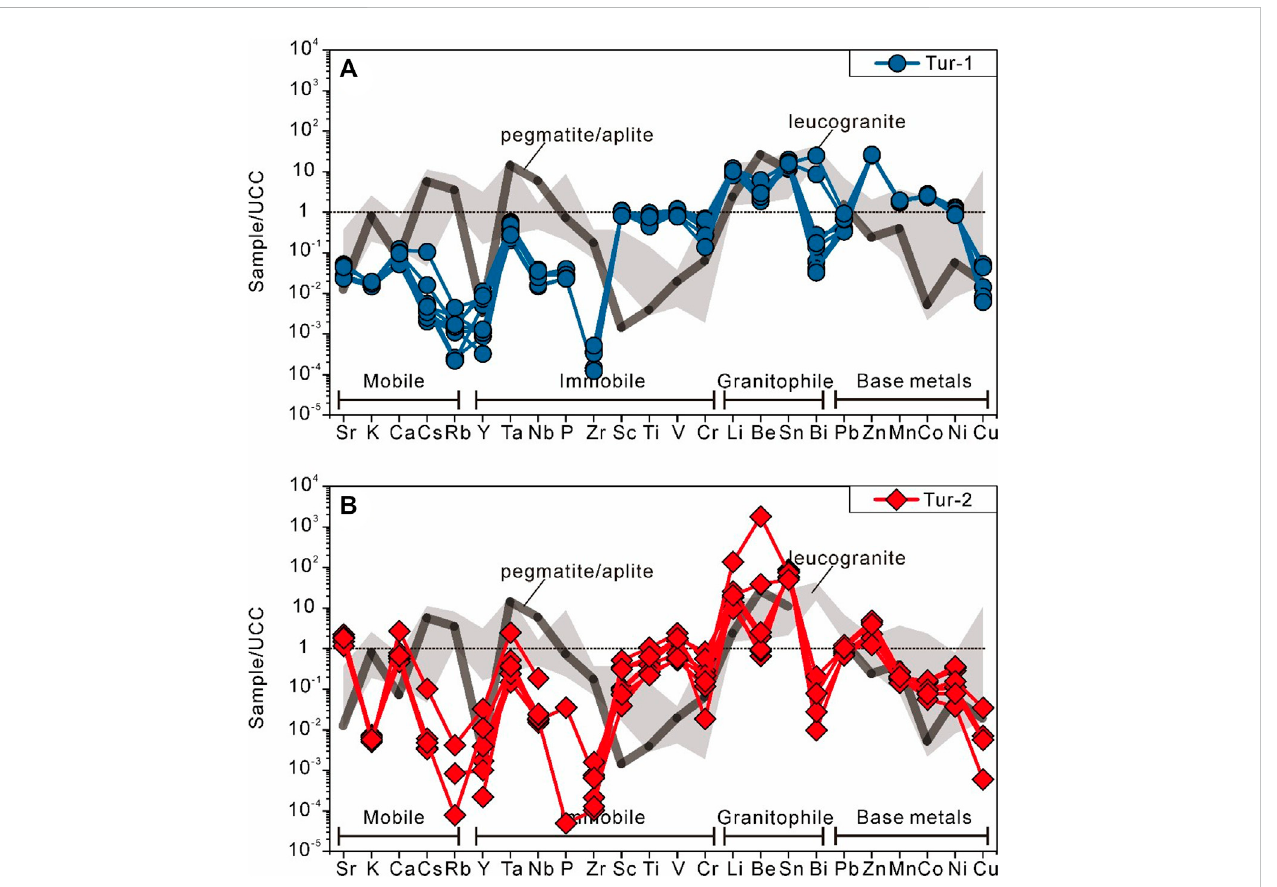
FIGURE 5 Upper continental crust-normalized spider diagram of Tur-1 and Tur-2 from the Cuonadong polymetallic deposit. The upper continental crust data and the classi fi cation of trace elements are from Rudnick and Gao (2003) and Decrée et al. (2013). The whole-rock major and trace element data on Cuonadong leucograniteandpegmatite/apliteintheXianglinareaarefromHuangetal.(2018),Xieetal.(2018),Xiaetal.(2019a),andXieetal.(2020). (A) Uppercontinental crust-normalized spider diagram of Tur-1 is shown as blue circle and line. (B) Upper continental crust-normalized spider diagram of Tur-2 is shown as red rhombus and